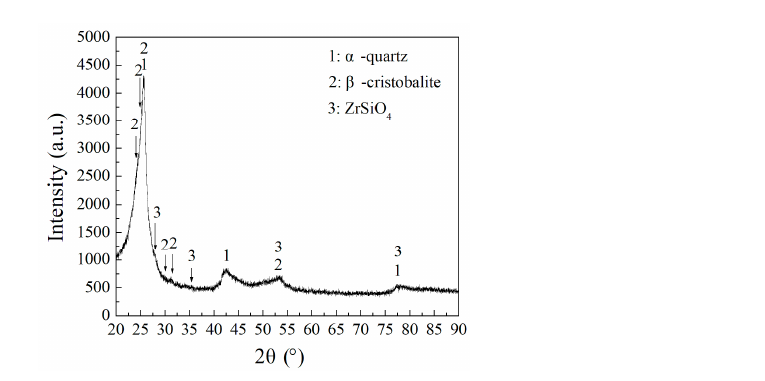
Figure 10. XRD pattern of oxyacetylene ablated surface of laser cladding coating.